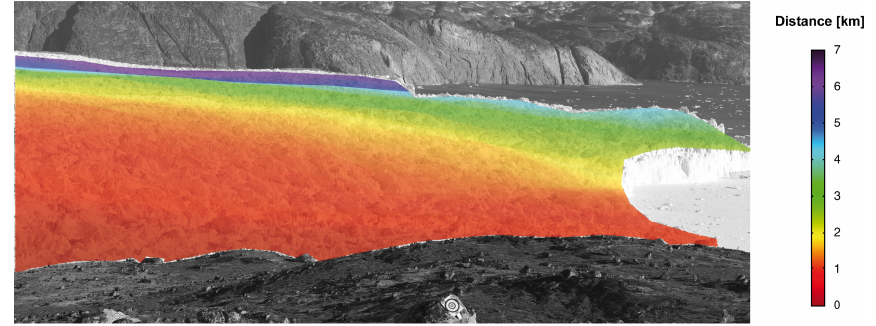
Figure 12. Distance map.